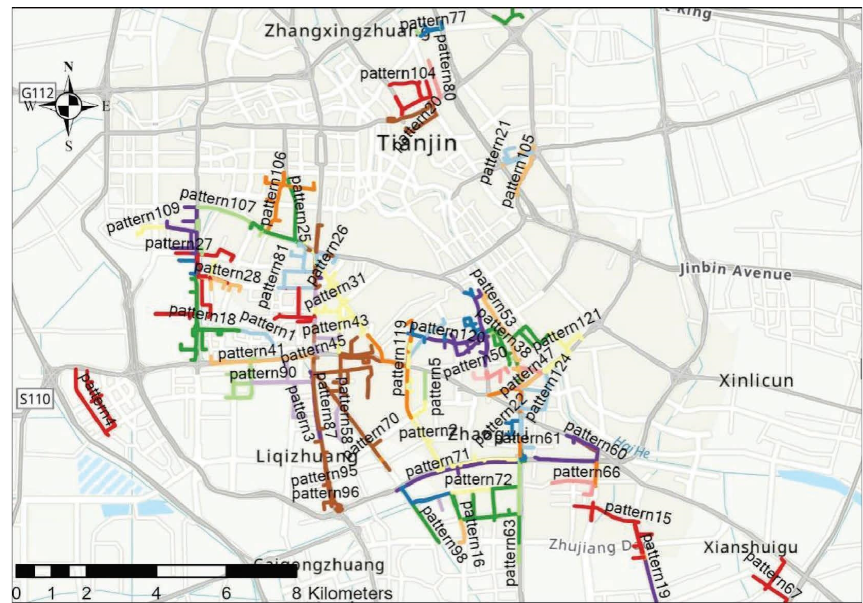
Figure 8: Frequent patterns on September 10 to 14 (8:00 to